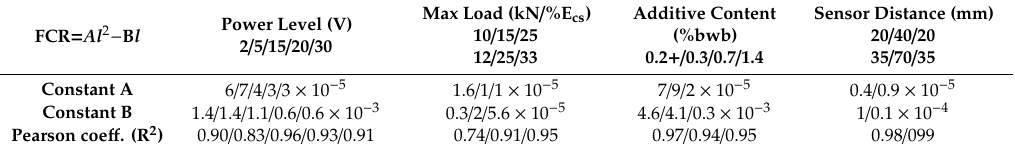
Table 6. Polynomic fitting of FCR and load relationship, AB constant, and Pearson coe ffi cient variation. FCR = Al 2 − B